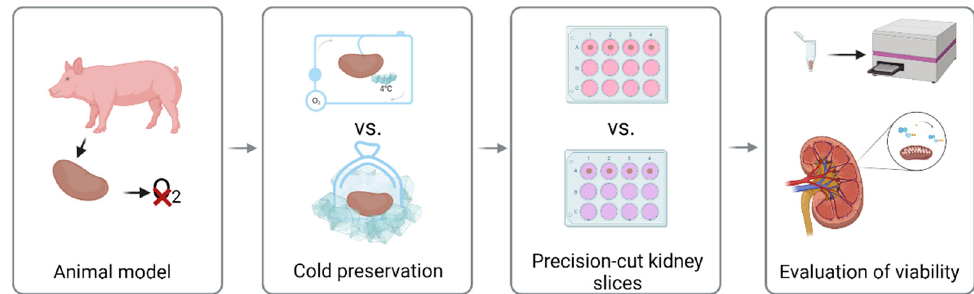
Figure 1. Experimental design of porcine precision-cut kidney slices.